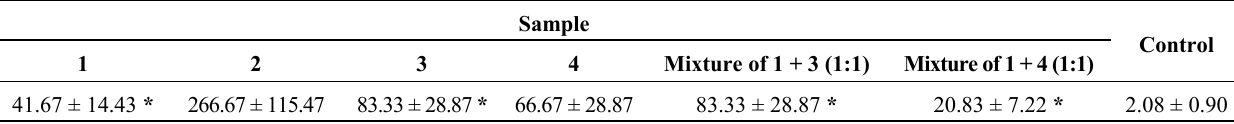
Table 2. MIC values (µg/mL) of constituents from R . ternatus against M . tuberculosis .